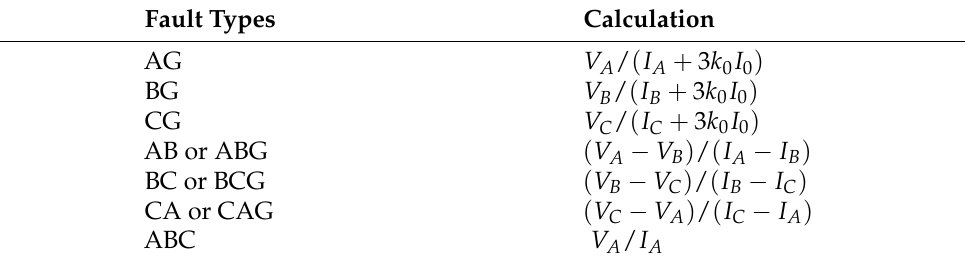
Table 2. Impedance calculations for different fault